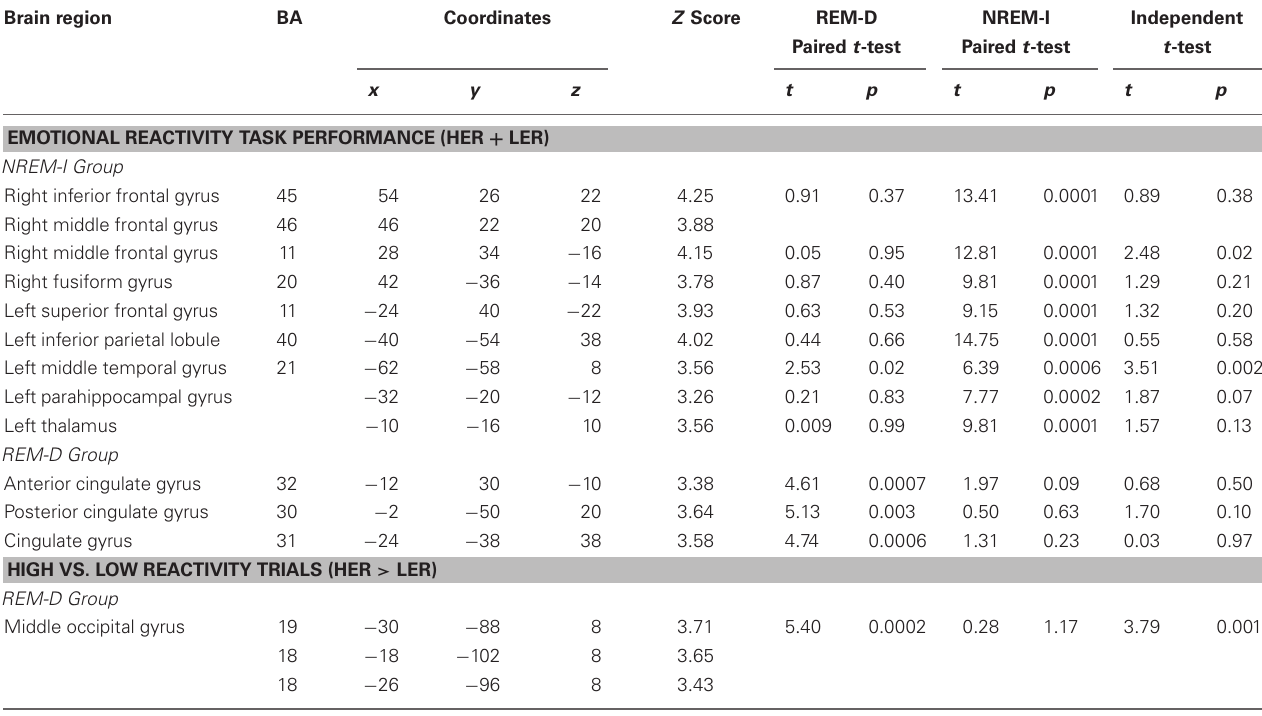
Table 3 | Activations during the emotional reactivity task after sleep manipulation. Brain region